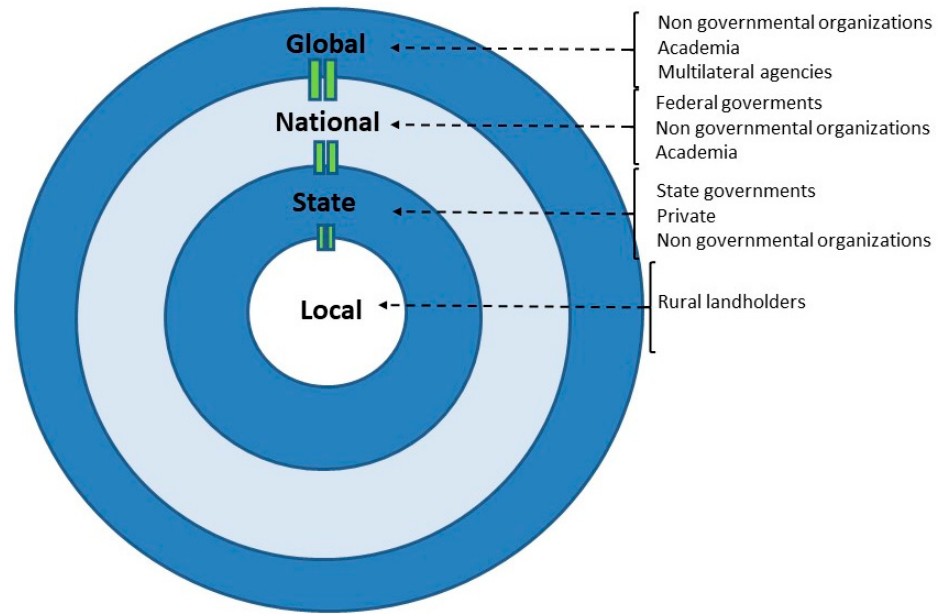
Figure 1. Nested scales where actors are involved in FLR planning and implementation work. The size of the equal sign denotes our hypothesis regarding diminishing similarity in the narratives when one moves from the global to the local scale. We gathered global narratives from peer reviewed and gray literature, whereas national, state and local narratives were gathered using semi-structured interviews. Private actors include sugar, pulp and restoration practitioners. This figure depicts the case of Brazil as scales and actor types may change in other parts of the world, where, for example, private property may not be the main form of land tenure.